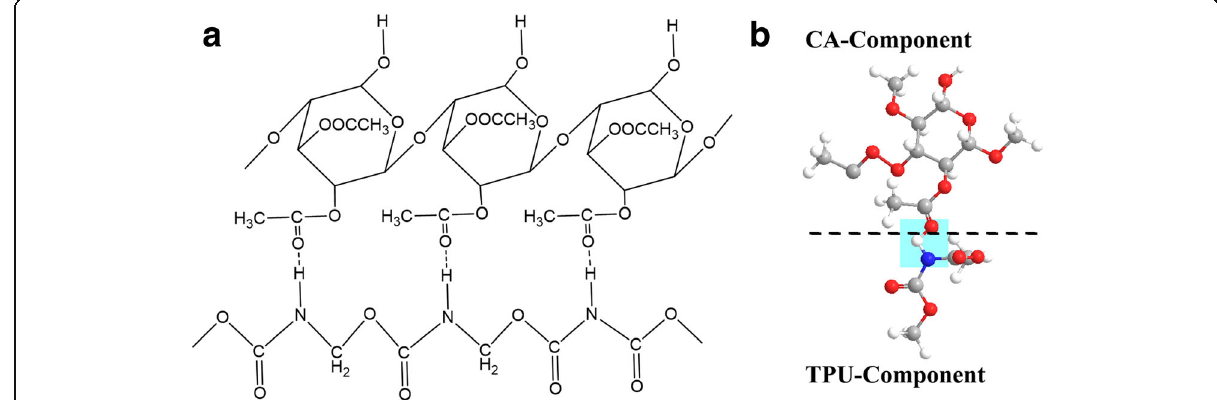
Fig. 7 a , b Hydrogen bonding between polymer chains of CA component and TPU